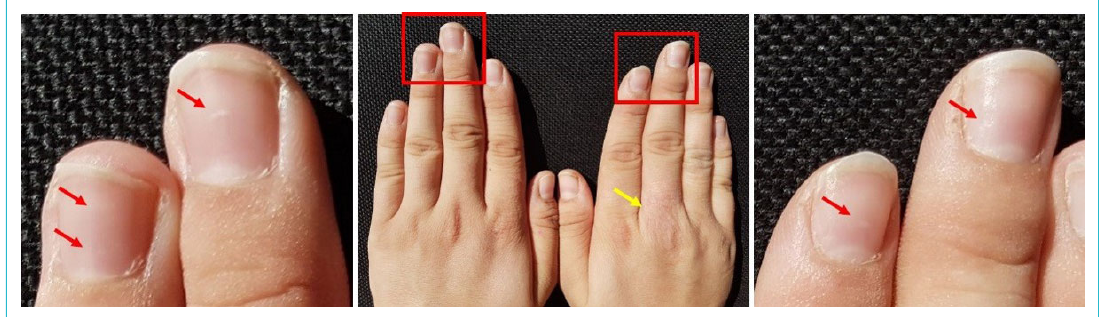
Figure 1: Bilateral spotted leukonychia (red insets, red arrows) and eczema (yellow arrow) in the patient.